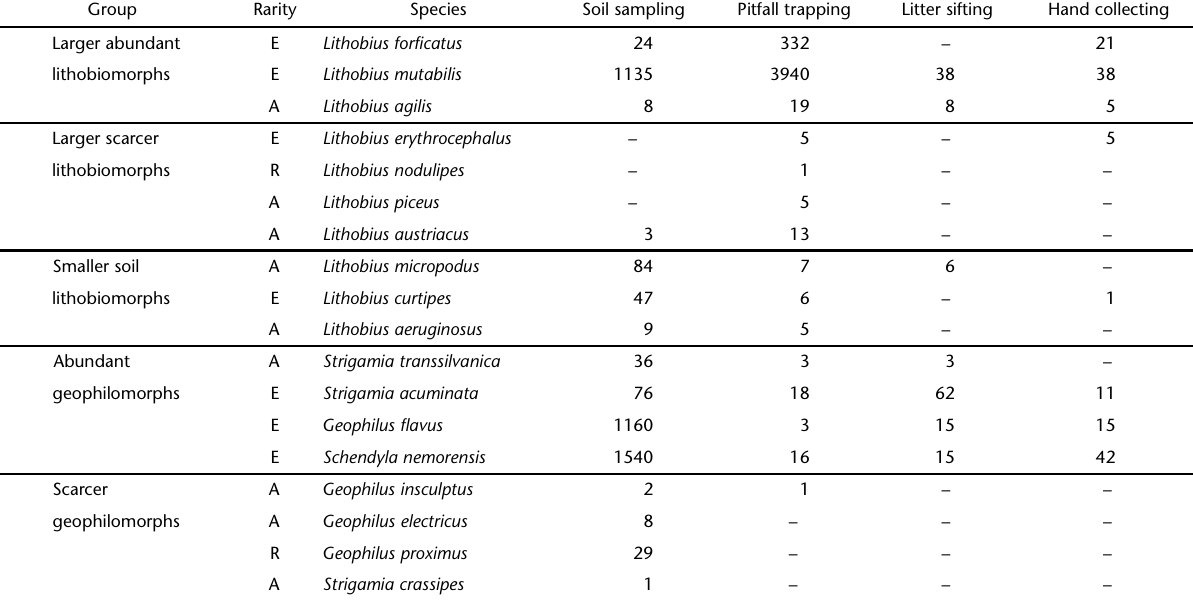
Table 3. Main groups of centipede species according to similar pattern of efficiency of individual methods (number of individuals) in Litovelské Pomoraví PLA. Rarity – ecological valence in Central European conditions (T UF & T UFOVÁ 2008): (R) relic species, (A) adaptable species, (E) eurytopic